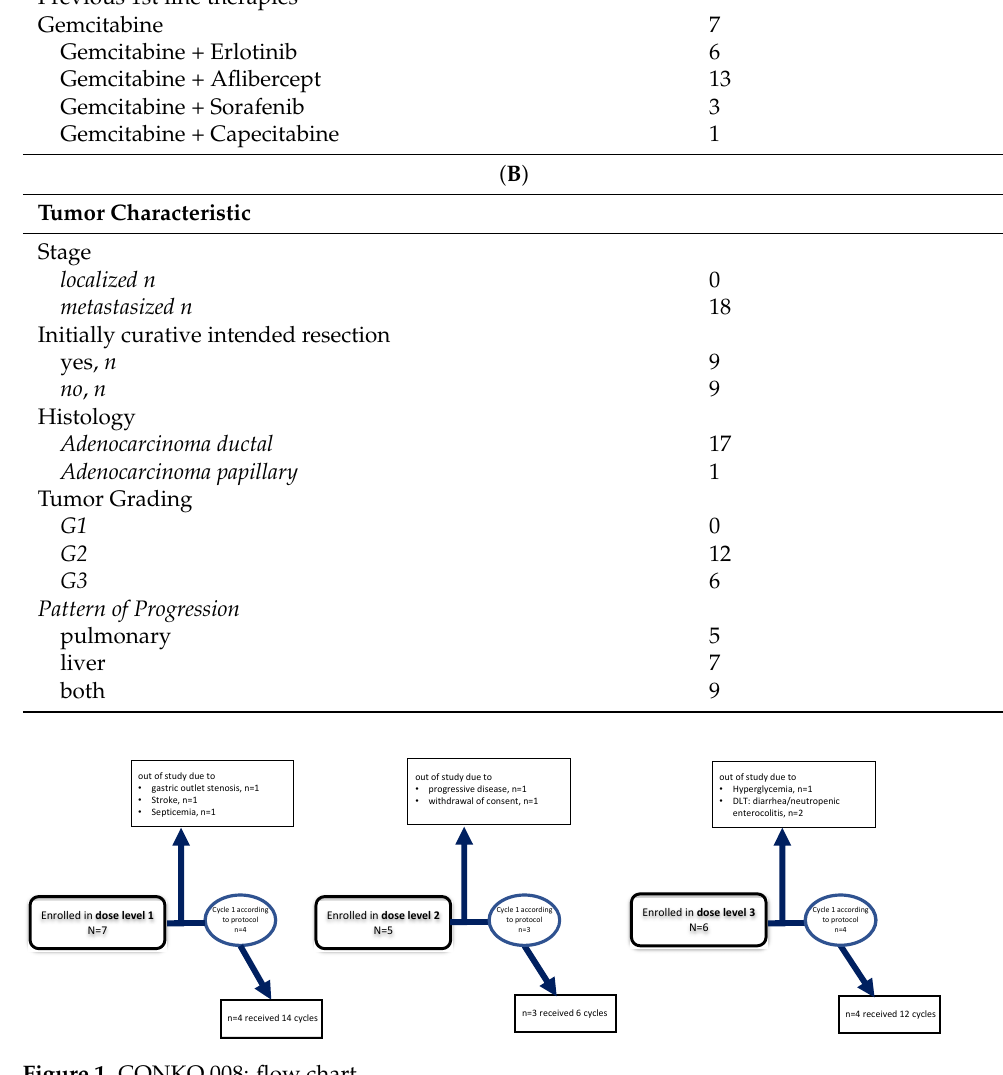
Figure 1. CONKO 008: flow chart.